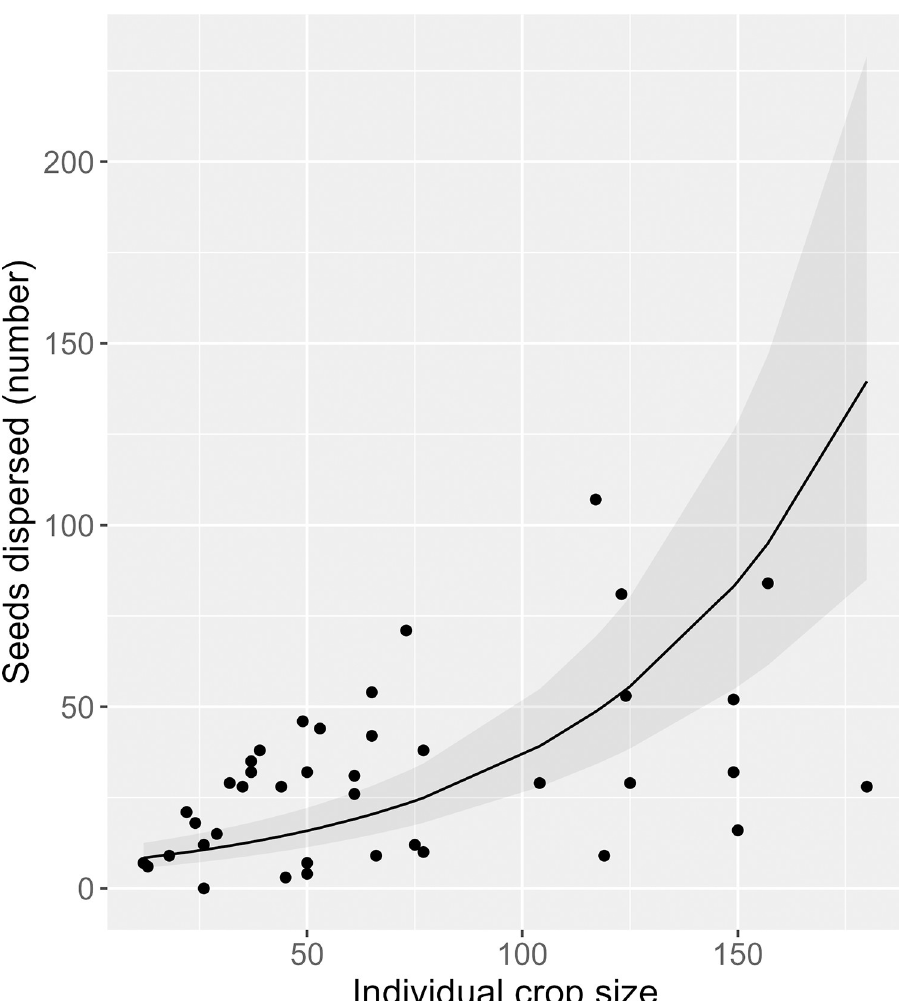
Fig 2. Relationship between the number of Lindera subcoriacea seeds dispersed and individual crop size. Points are individual observations, the line is from a mixed-effects generalized linear regression model (no quadratic term; reduced model), and the shaded region is the 95% confidence